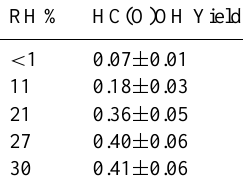
Fig. 5. Retrieved experimental values of [HC(O)OH] and kineti-